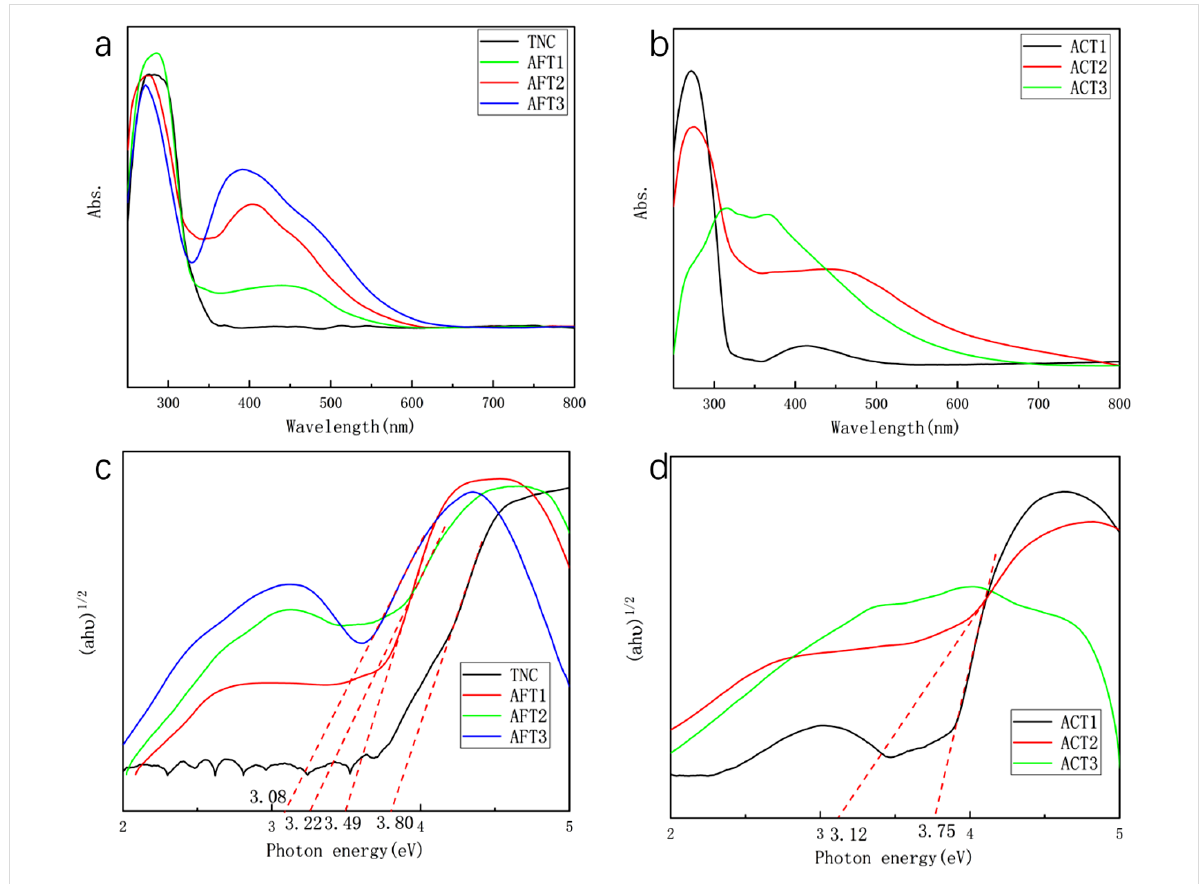
Figure 6: (a,b) UV–vis absorption spectra and (c,d) bandgaps of the different samples.